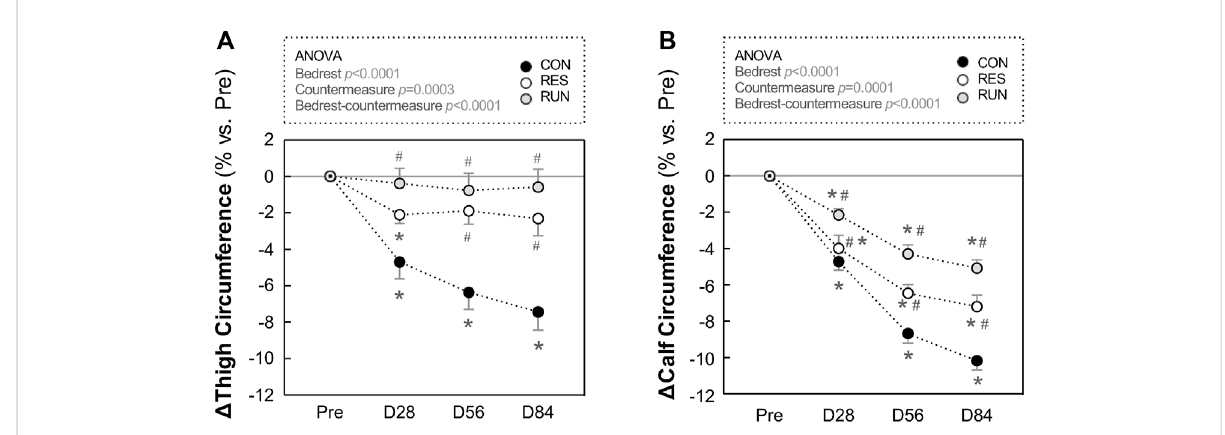
FIGURE 9 Evolution in thigh and calf circumferences during HDBR. Thigh (A) and calf (B) circumferences were measured in the – 6 ° position. The sample size was n = 8/CON, n = 7/RES, n = 7/RUN. Data are presented as the mean ± SEM. * p < 0.05 vs. Pre; # p < 0.05 vs.